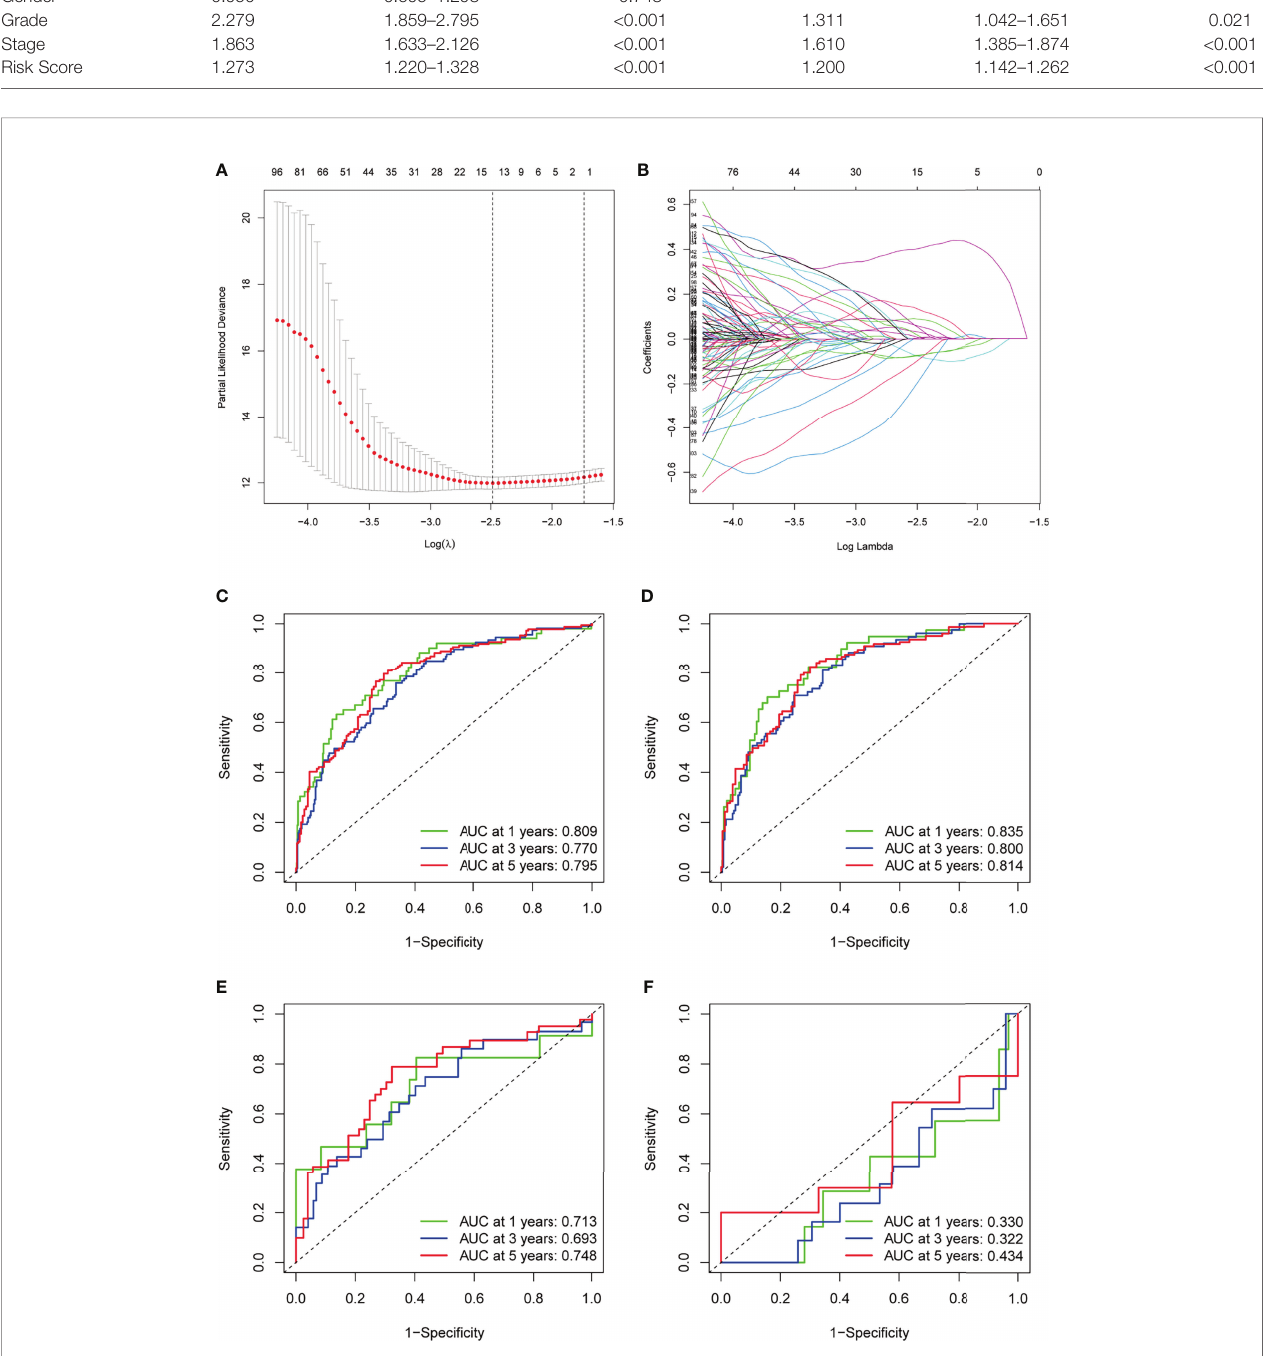
FIGURE 3 | Construction of the TME-related signature for KIRC. (A) LASSO coef fi cients of the prognostic TME-related gene. (B) The LASSO model parameters ( l ) were selected using a minimum criterion of ten cross-validations. (C – F) ROC curves for prognostic models of the entire TCGA cohort, TCGA training cohort, TCGA testing cohort, and GSE29609. TME, tumor microenvironment; KIRC, kidney renal clear cell carcinoma; LASSO, least absolute1 shrinkage and selection operator; ROC, receiver operating characteristic.